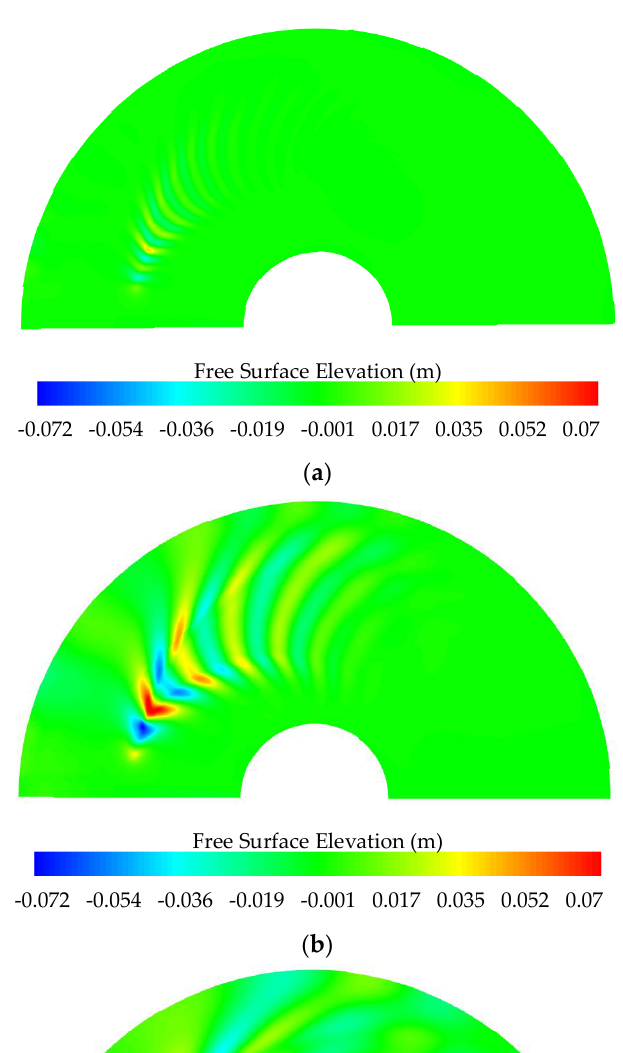
Figure 8. Development of wakes at the free surface at Fr = 0.5. ( a ) t = 5 s, ( b ) t = 10 s, ( c ) t = 15 s.